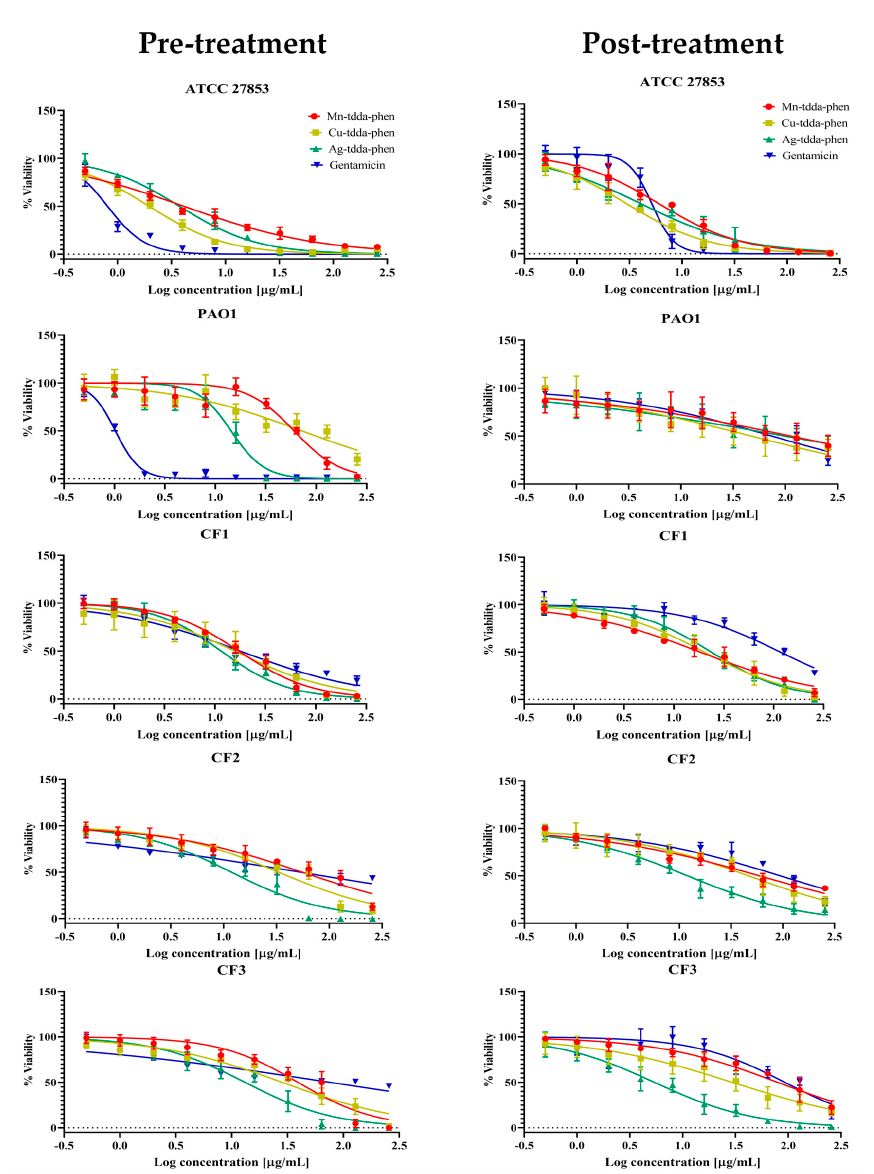
Figure 1. Cell viability—Effect of metal-tdda-phen complexes (Mn-tdda-phen, Cu-tdda-phen and Ag-tdda-phen) and gentamicin on both inhibiting biofilm formation (pre-treatment) and dismantling established biofilms (post-treatment) of laboratory strains (ATCC 27853 and PAO1) and clinical isolates (CF1-CF3).